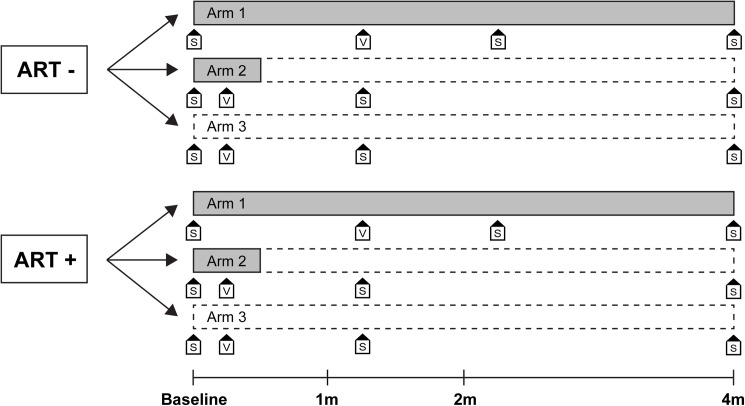
Study overview.COX-2i treatment duration indicated in grey. S, blood sampling; V, vaccination.